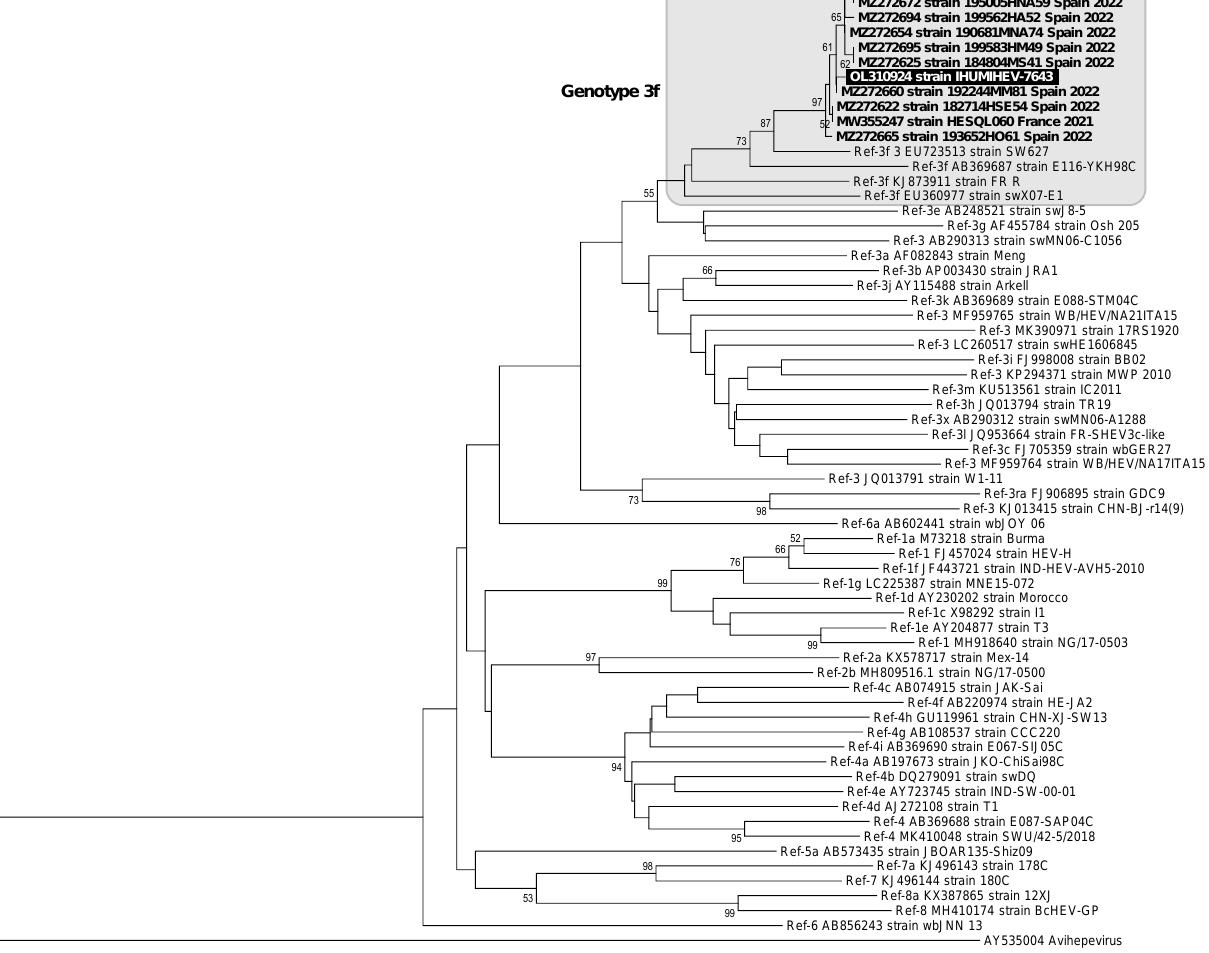
Figure 1. The fragment of the ORF2 gene encoding for the capsid protein was 315-nucleotide long and corresponded to nucleotides 6016–6330 of the HEV genome GenBank accession no. JQ953664. The HEV sequence obtained by Sanger sequencing from the present case is indicated by a white bold font and a black background. The 10 sequences with the highest BLAST scores recovered from the NBCI GenBank nucleotide sequence databases (http://www.ncbi.nlm.nih.gov/nucleotide/, accessed on 17 September 2022), indicated by bold font, were incorporated in the phylogeny reconstruction, in addition to reference sequences for the HEV genotypes [2]. Nucleotide alignments were performed using the MUSCLE software (http://www.ebi.ac.uk/Tools/msa/muscle/, accessed on 17 September 2022). The evolutionary history was inferred in the MEGA6 software (http://www.megasoftware.net/, accessed on 17 September 2022) using the Neighbor-Joining method and the Kimura 2-parameter method. The percentage of replicate trees in which the associated taxa clustered together in the bootstrap test (1000 replicates) is shown next to the branches. The tree is drawn to scale, with branch lengths in the same units as those of the evolutionary distances used to infer the phylogenetic tree; the scale bars indicate the number of nucleotide substitutions per site. Bootstrap values > 50% are labeled on the